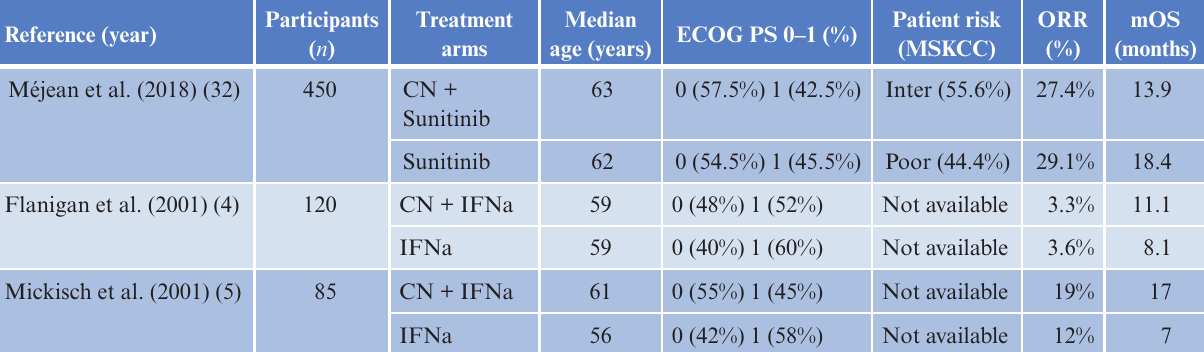
Table 2. Prospective trials comparing nephrectomy followed by systemic therapy versus systemic therapy alone in